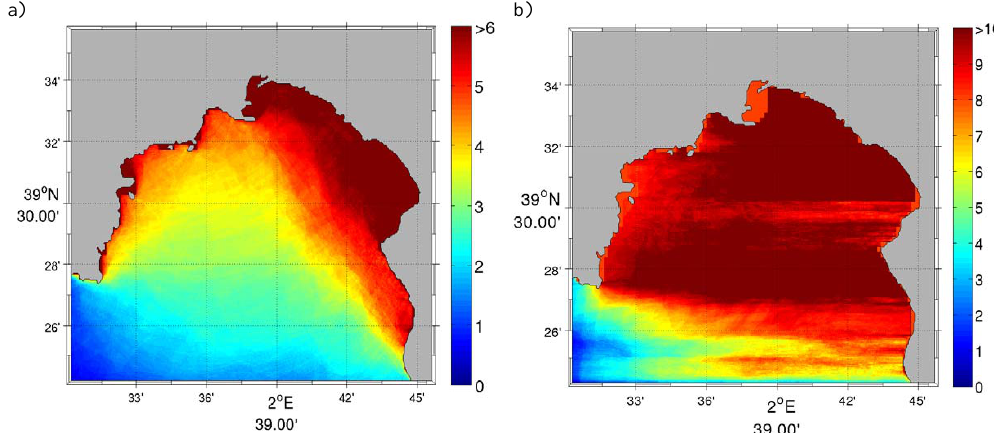
Fig. 8. Spatial distributions of time averages of 60 snapshots of 6-hourly RT values collected over 15 days in the Bay of Palma for (a) October and (b) July. The color bar units are days.